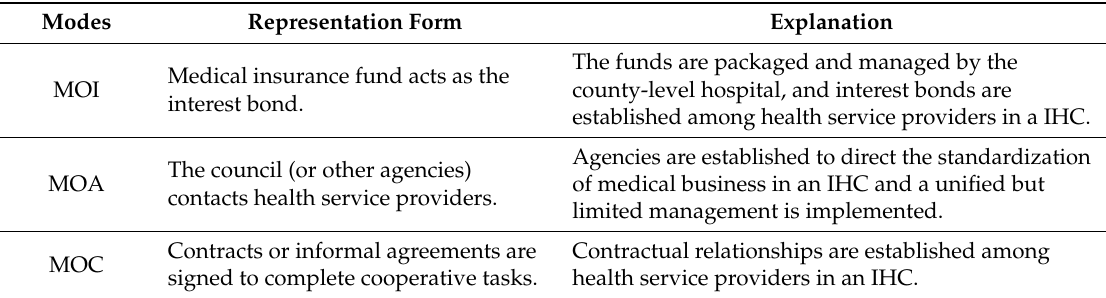
Table 1. Classification and explanation of IHC